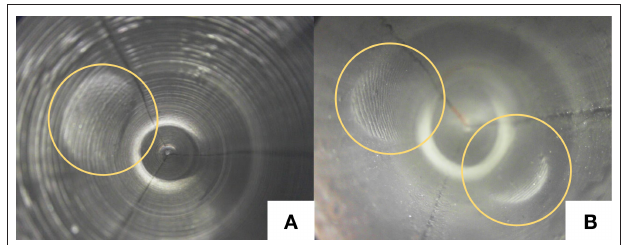
FIGURE 7 | Elastomer textures obtained using (A) fused filament fabrication (FFF) and (B) stereolithography (SLA) 3D printers. As highlighted in (B) , the ridges of human fingerprints are camouflaged by the elastomer